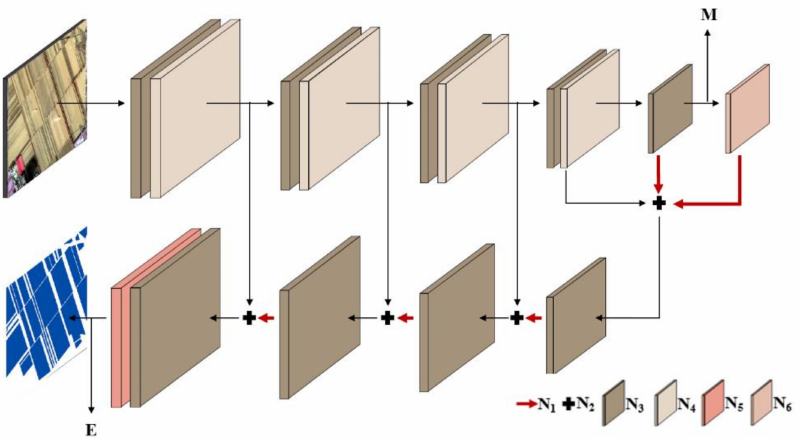
Figure 3. MSCU-net architecture. N1: Up-sampling of the image feature with a 2 × 2 window size; N2: Feature image fusion; N3: The repeated application of two 3 × 3 convolutions followed by batch normalization; N4: Max pooling with 2 × 2 window size for down-sampling; N5: Attention mechanism module; N6: Multiscale Convolution Group (MSCG); M: Loss function of the intermediate layer, E: Loss function of high